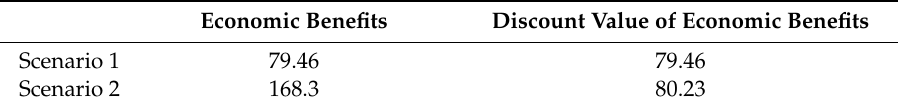
Table 4. Economic benefit and discount value (10 10 CNY).